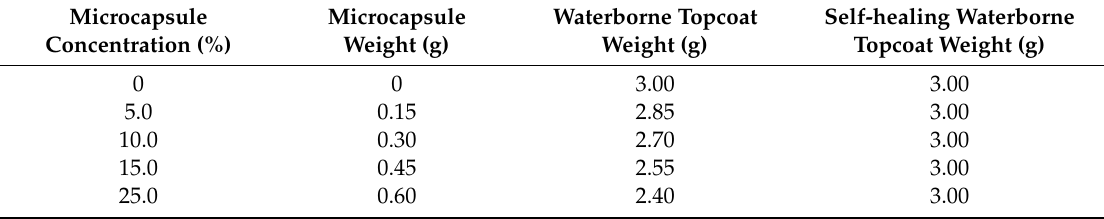
Table 2. The composition of waterborne topcoat with